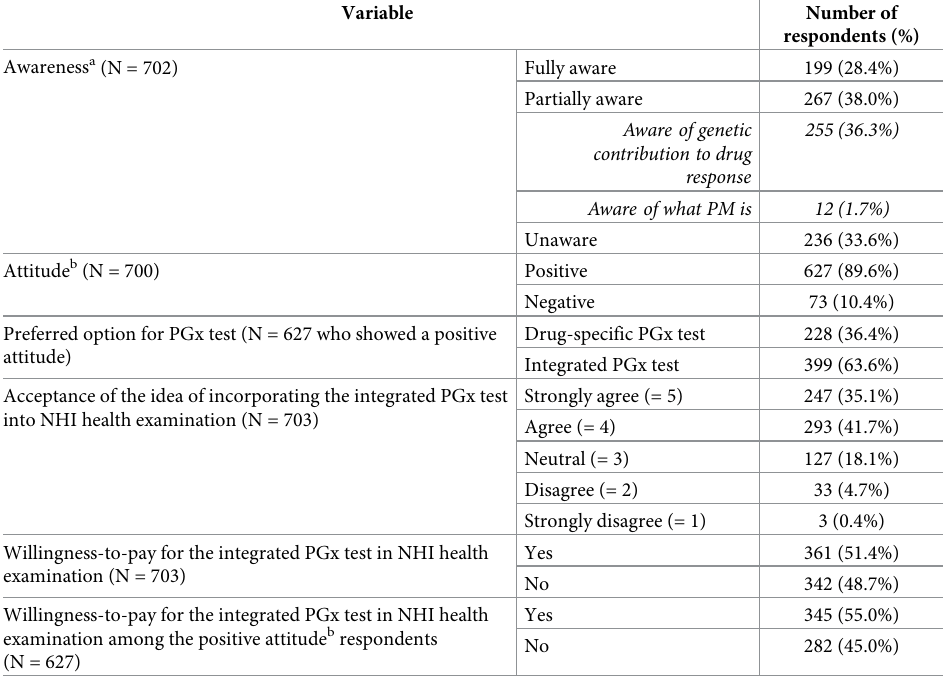
Table 2. Awareness and attitudes of the general public toward personalized medicine using pharmacogenomic